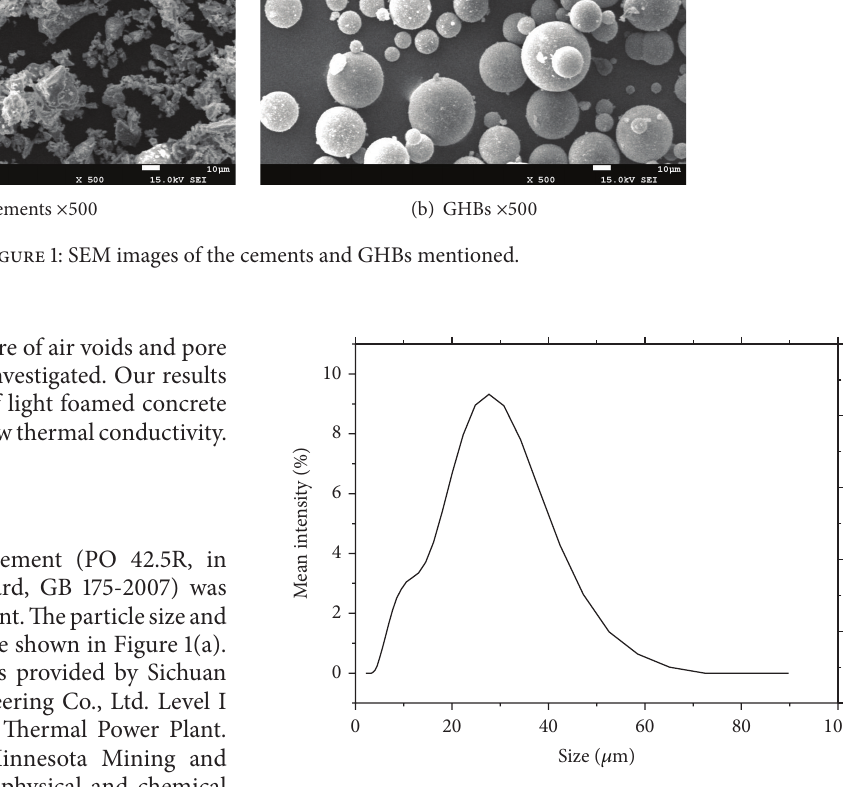
Figure 2: Particle size distribution of